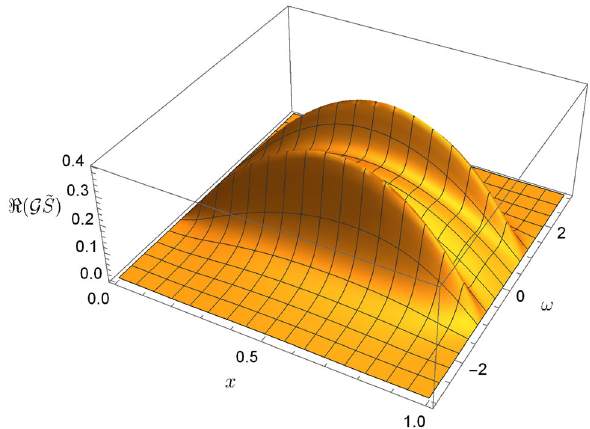
Fig. 1 The frequency-domain Green’s function integrated by the (cid:14) dr (cid:10) G (ω, r , r (cid:10) ) S (ω, r (cid:10) ) , for a given angular momentum com- source ponent (cid:2) = 2. Here the radial coordinate is expressed in ¯ x = ( r − r h )/